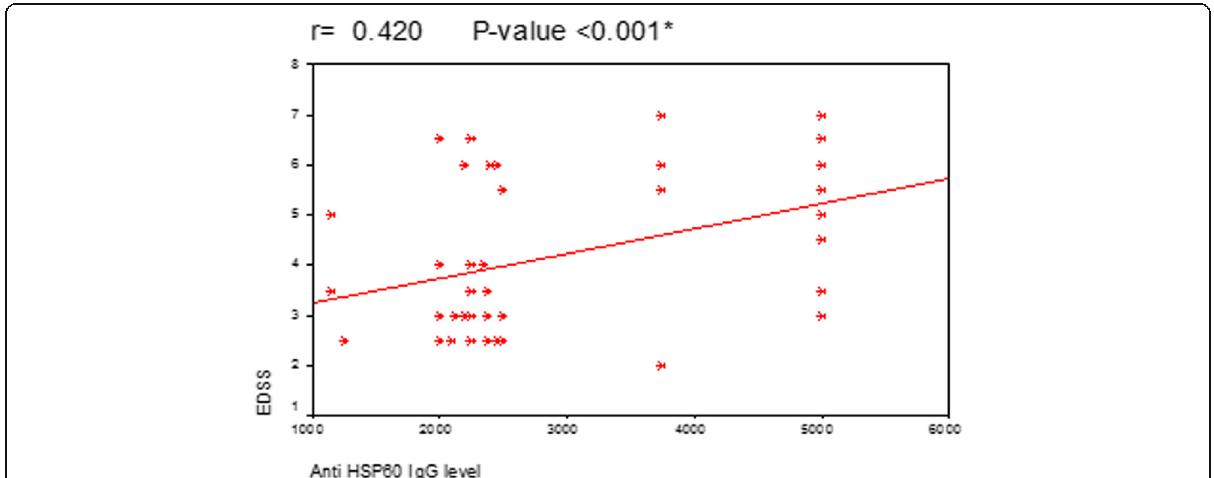
Fig. 3 Correlation between anti Hp hsp60 IgG level and EDSS of MS